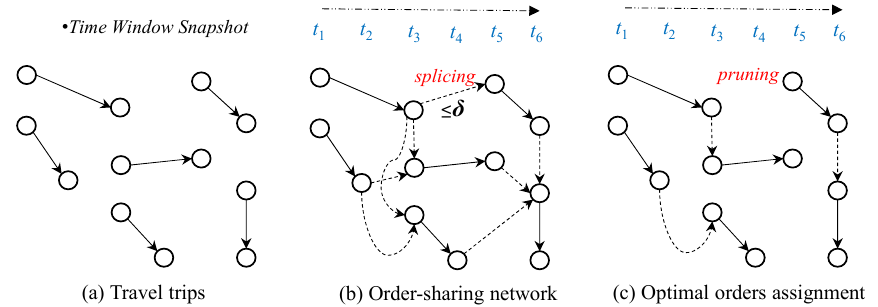
Figure 2. The construction of the trajectory sharing network. The network is spliced using the parameter δ and satisfies the temporal constraint. According to the trip origin and destination ( a ), if − t o ≤ δ between the drop-off point of the first trip and the pickup point of the next trip, splicing is performed. The maximum matching algorithm generates a set of paths covering the entire graph ( b ), ensuring that all trips are served while minimizing the number of paths ( c ).